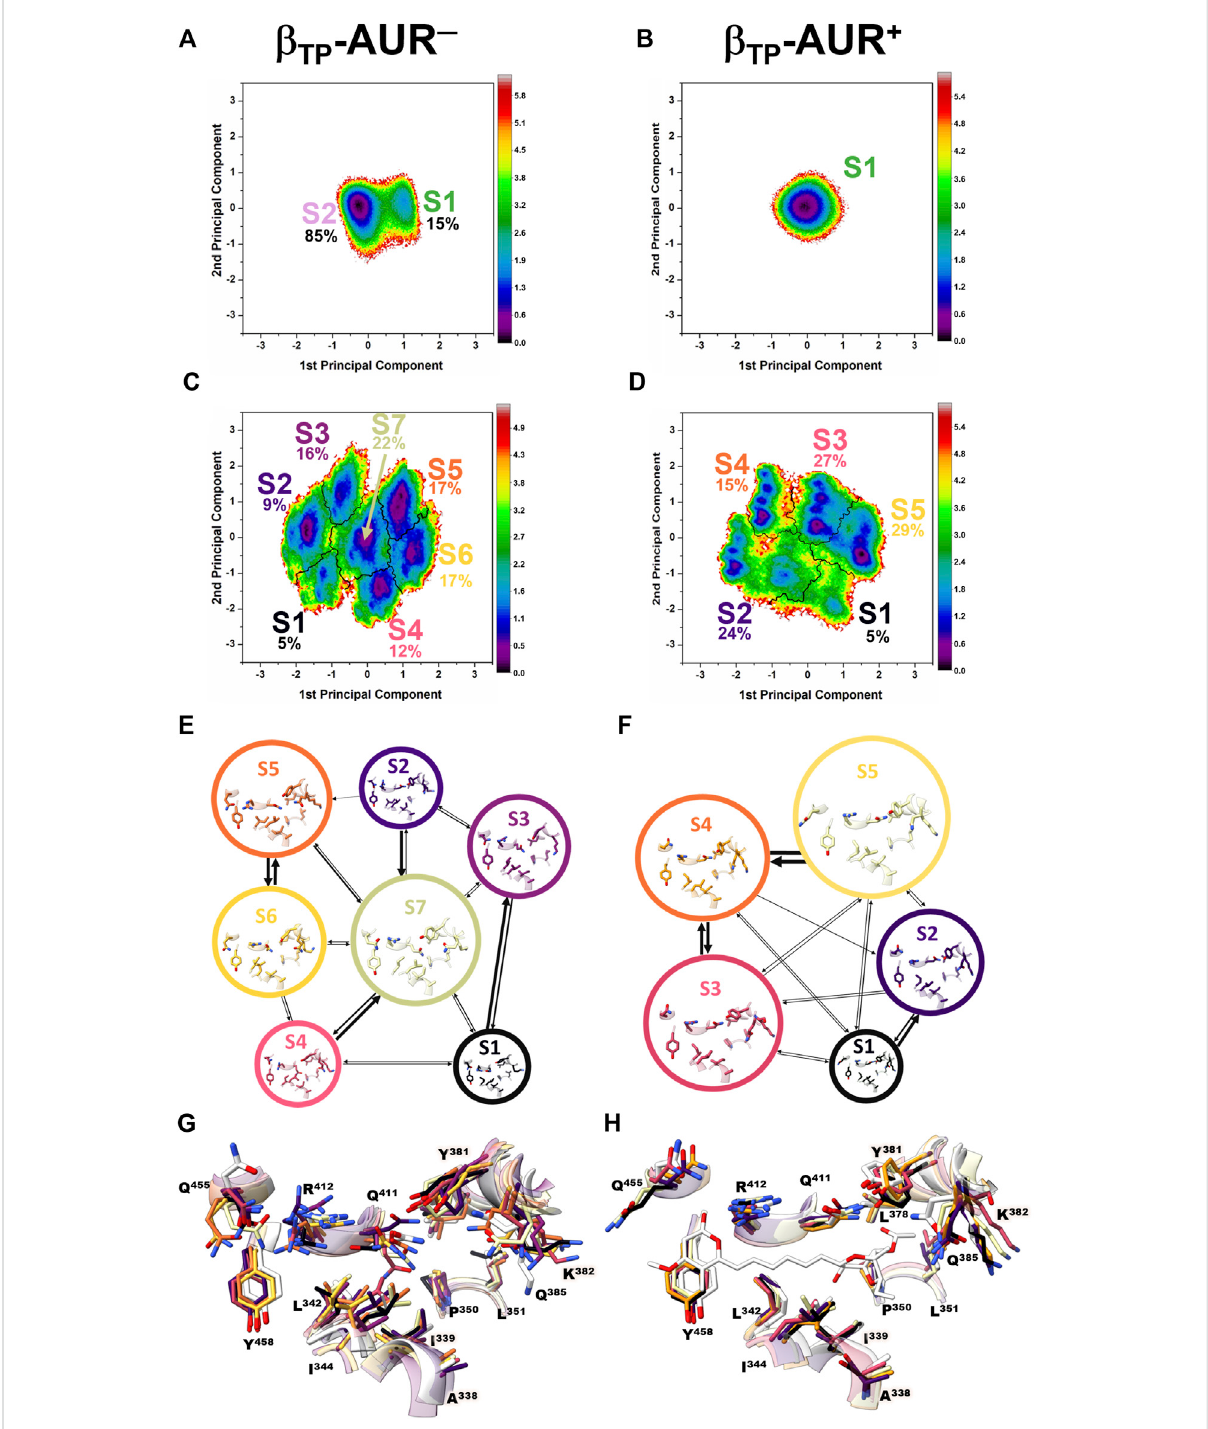
FIGURE 4 Dihedralanglefreeenergylandscapes(FEL)fortheAURbindingsiteresiduesin β TP . FEL(in k B Tunits)wereobtainedfromadPCAprojectedonto the fi rst twoprincipalcomponents intheabsence (left column)and presence (rightcolumn)oftheinhibitor. (AandB) BackbonedPCA.Oneand two metastable conformational states were observed for AUR + (S1) and AUR ─ (S1, S2), respectively. The percentage of cumulative frequency is indicated. The main difference between S1 and S2 was the ψ angle value of I 344 . (C and D) Side chain dPCA. The black lines delimit the macrostates identi fi ed through a Markov-state model analysis. (E and F) Network transition pathway of the Markov-state model. The thickness of the connecting arrows is proportional to the transition probability. (G and H) Superimposition of representative conformations for each attraction basin in (E and F) . Macrostates were labeled S1, S2 and so on from lowest to highest